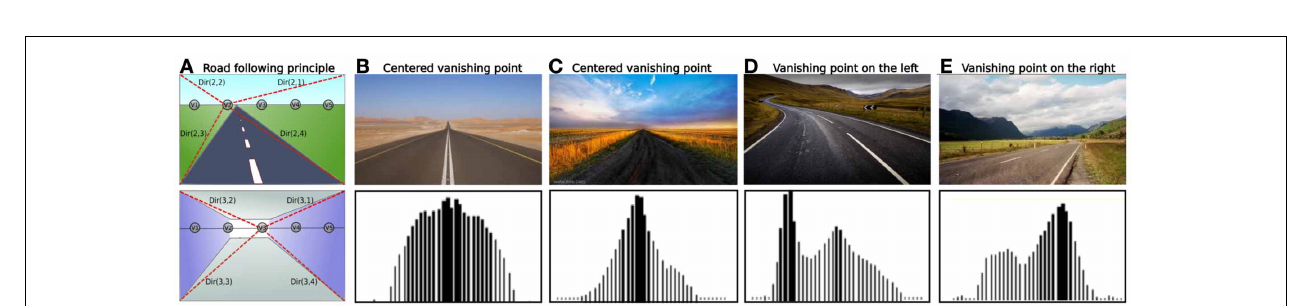
FIGURE 2 | (A) Activity of 4 PCs recorded on a linear track in a real outdoor environment. Each maximum of activity corresponds to the learned position of the corresponding PC. Our architecture provides good generalization properties since activities present large place field.